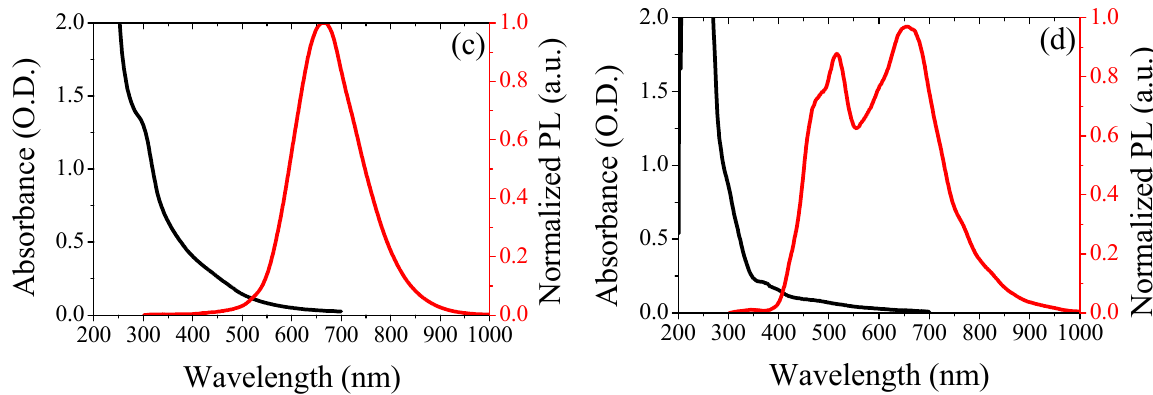
Figure 1. UV-Vis absorption (black lines) and normalized PL emission (red lines) spectra of: ( a ) photoinitiator Irgacure 819, ( b ) PEGDA 700 , ( c ) AgNCs-PMAA in aqueous solution, ( d ) solid hydrogel matrix of PEGDA 700 with AgNCs-PMAA. The HRTEM images of the AgNCs-PMAA after the centrifugation process and before the embedding in the hybrid matrix is reported in Figure 2a,b, highlighting a mean size of 1.84 ± 0.60 nm. In Figure 2c, a picture of the solid optical device composed by the hy- drogel matrix inside a plastic cuvette is reported.